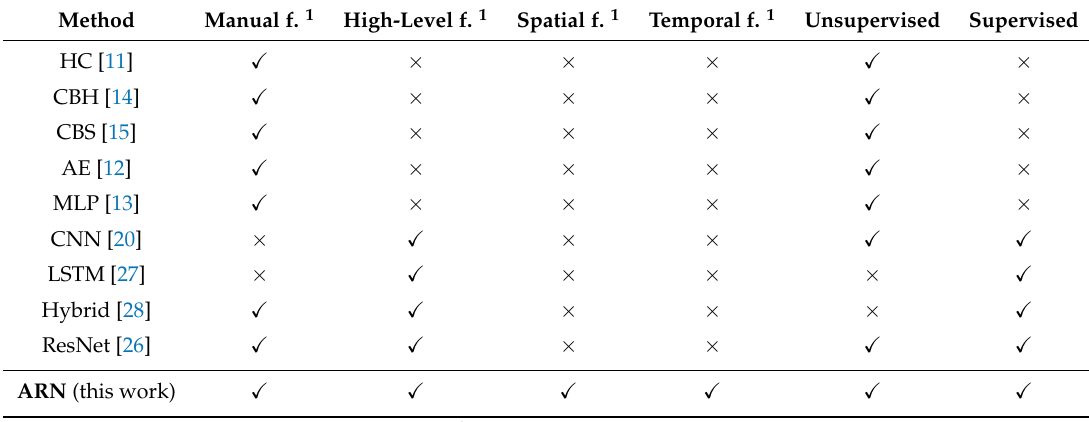
Table 1. Comparison of different human activity recognition (HAR)